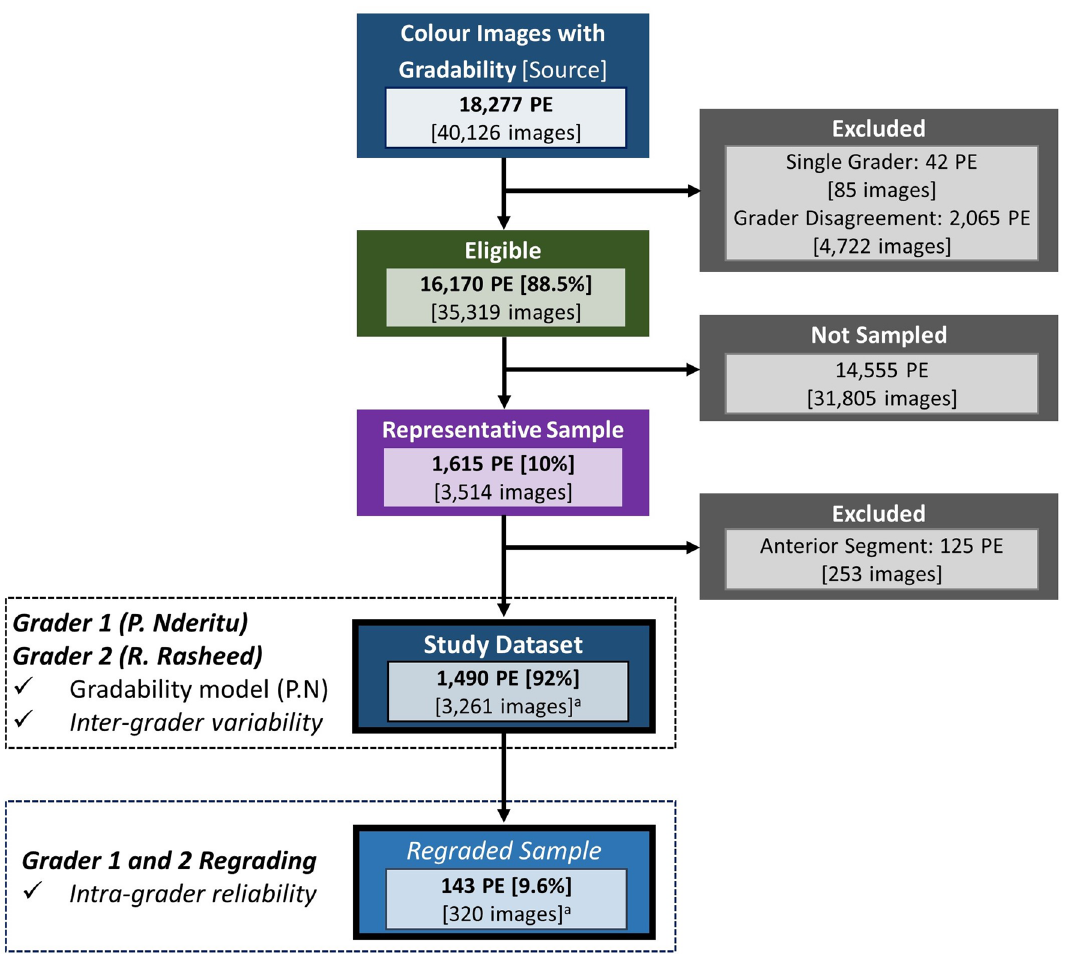
Figure 1. Data curation, sampling and study dataset construction. PE Patient eyes, a All images per patient eye were